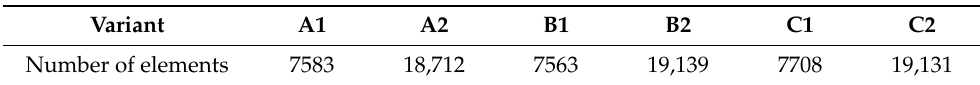
Table 3. Summary of the number of finite elements S3 and S4R depending on the analyzed geomet- ric variant.